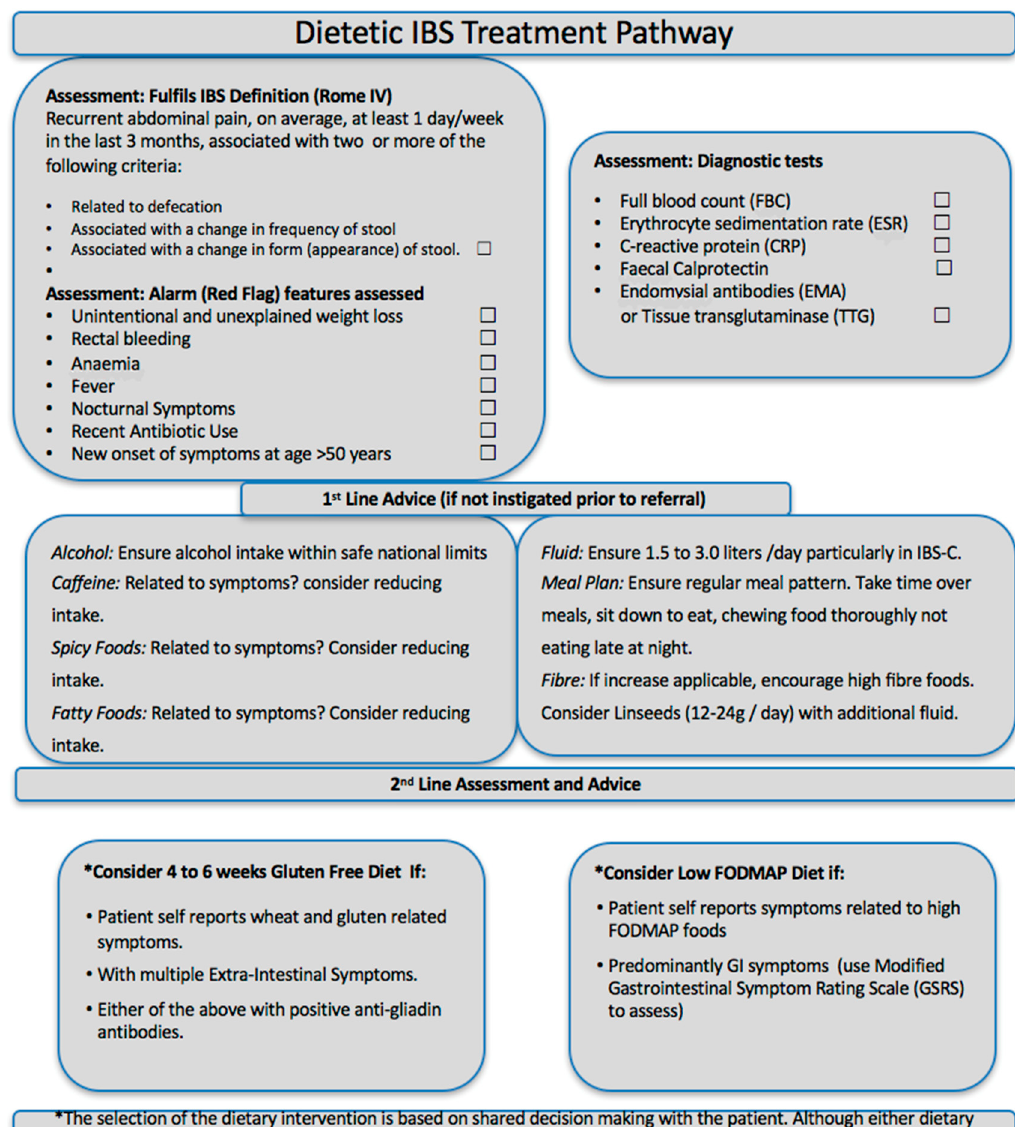
Figure 3. IBS treatment pathway.